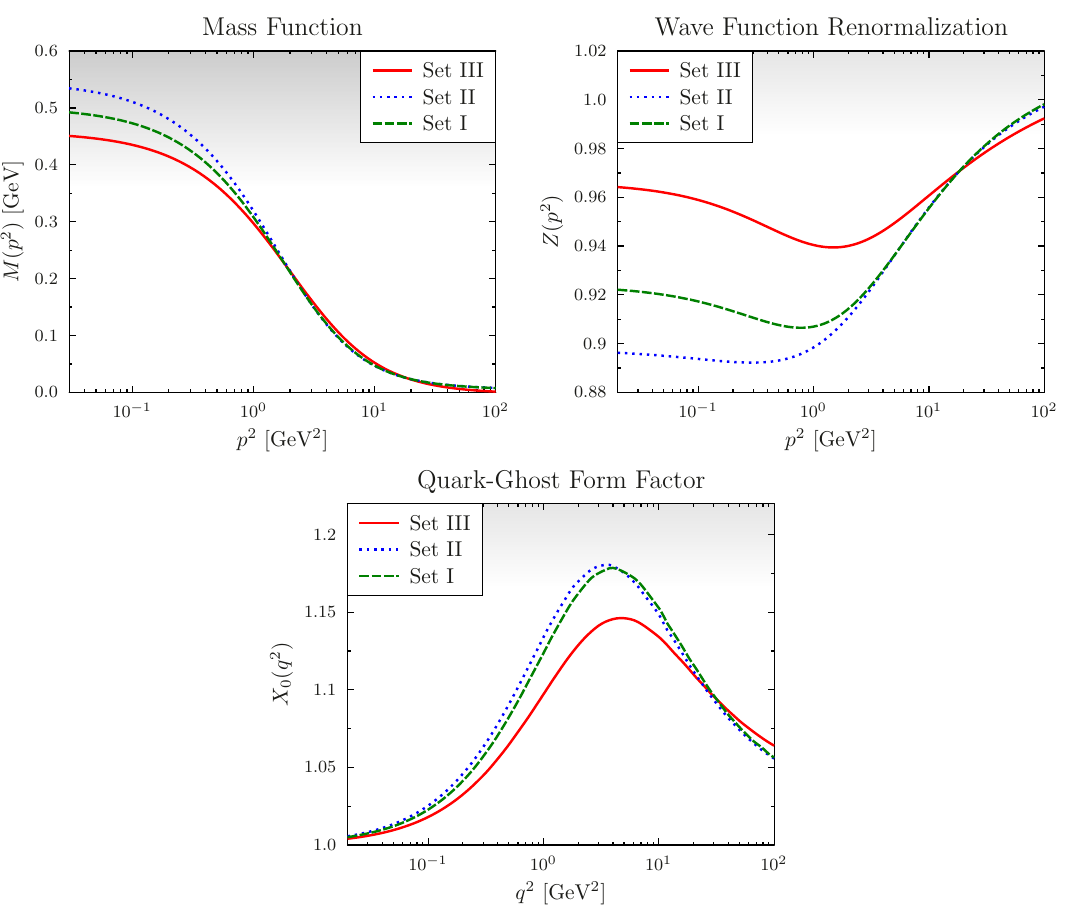
Figure 4 . Mass function, M ( p 2 ) , wave renormalization, Z ( p 2 ) , and leading quark-ghost kernel form factor, X 0 ( q 2 ) , obtained with three sets of gluon and ghost propagators, Γ µ ( k, p ) = Γ L Γ T ( k, p ) and associated form factors of eqs. (2.44)–(2.55) in the DSE (2.15). Current-quark µ